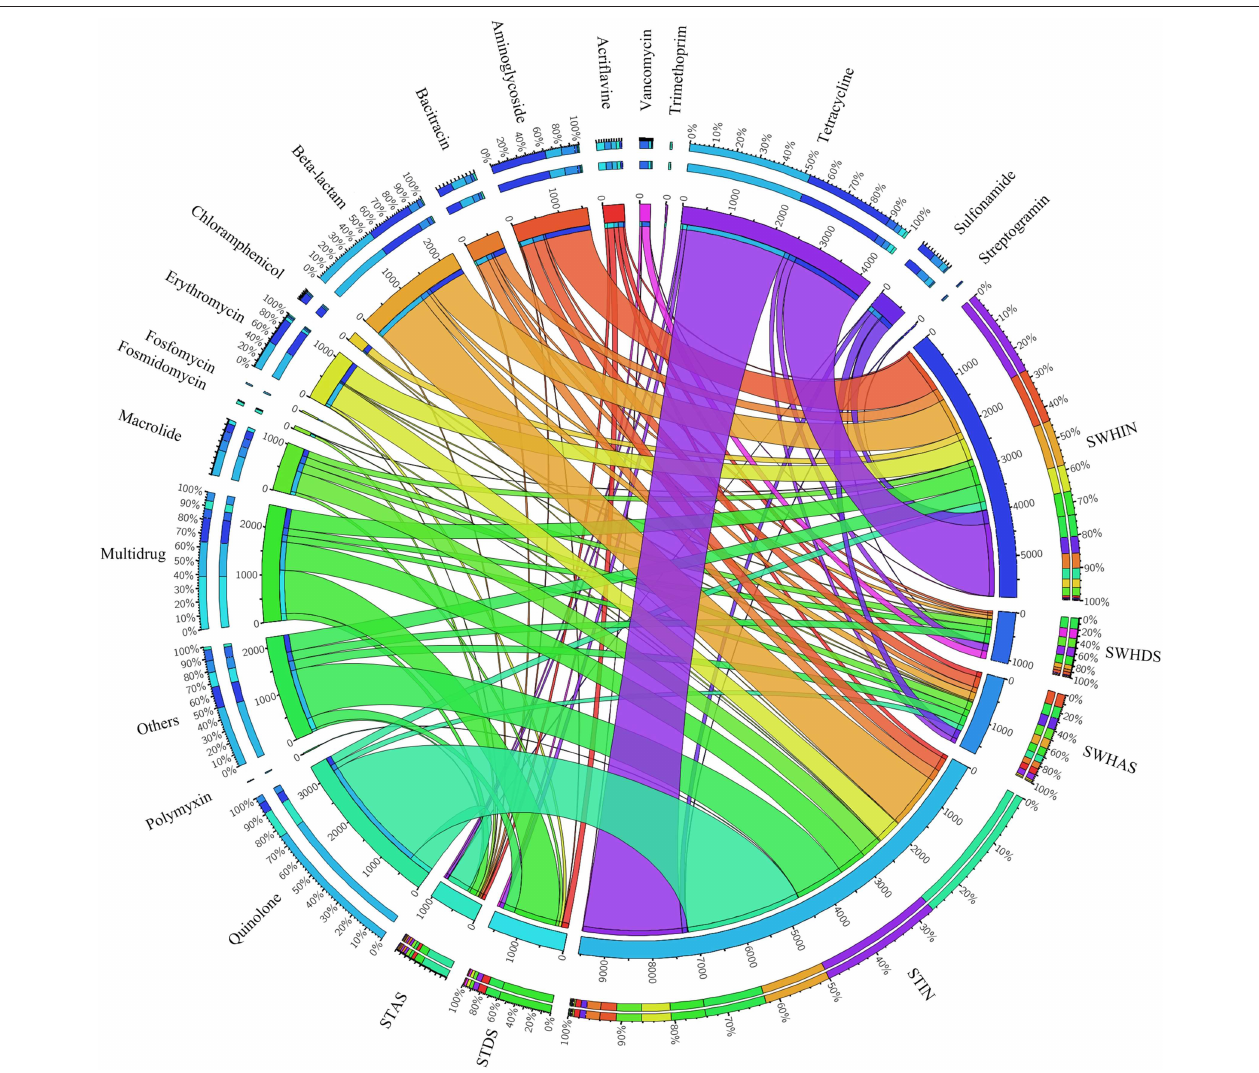
FIGURE 5 | Distributions of ARG types and their abundances in the total annotated ARGs in the six plasmid metagenomes (visualized via Circos). The length of the bars on the outer-ring represents the percentage of ARGs in each plasmid metagenome. Each ARG was represented by a specific ribbon color, and the width of each ribbon demonstrates the abundance of each ARG in the plasmid